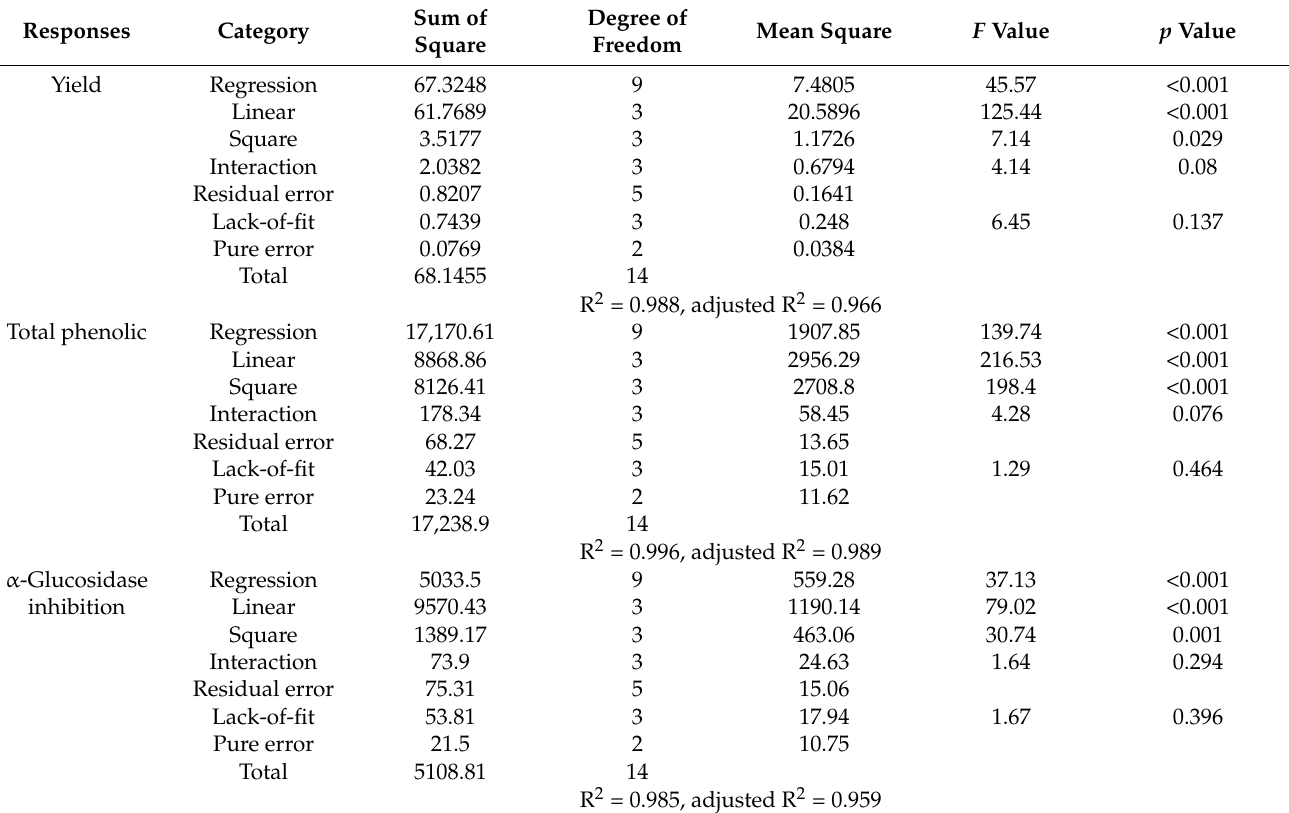
Table 4. ANOVA for response surface regression equation.